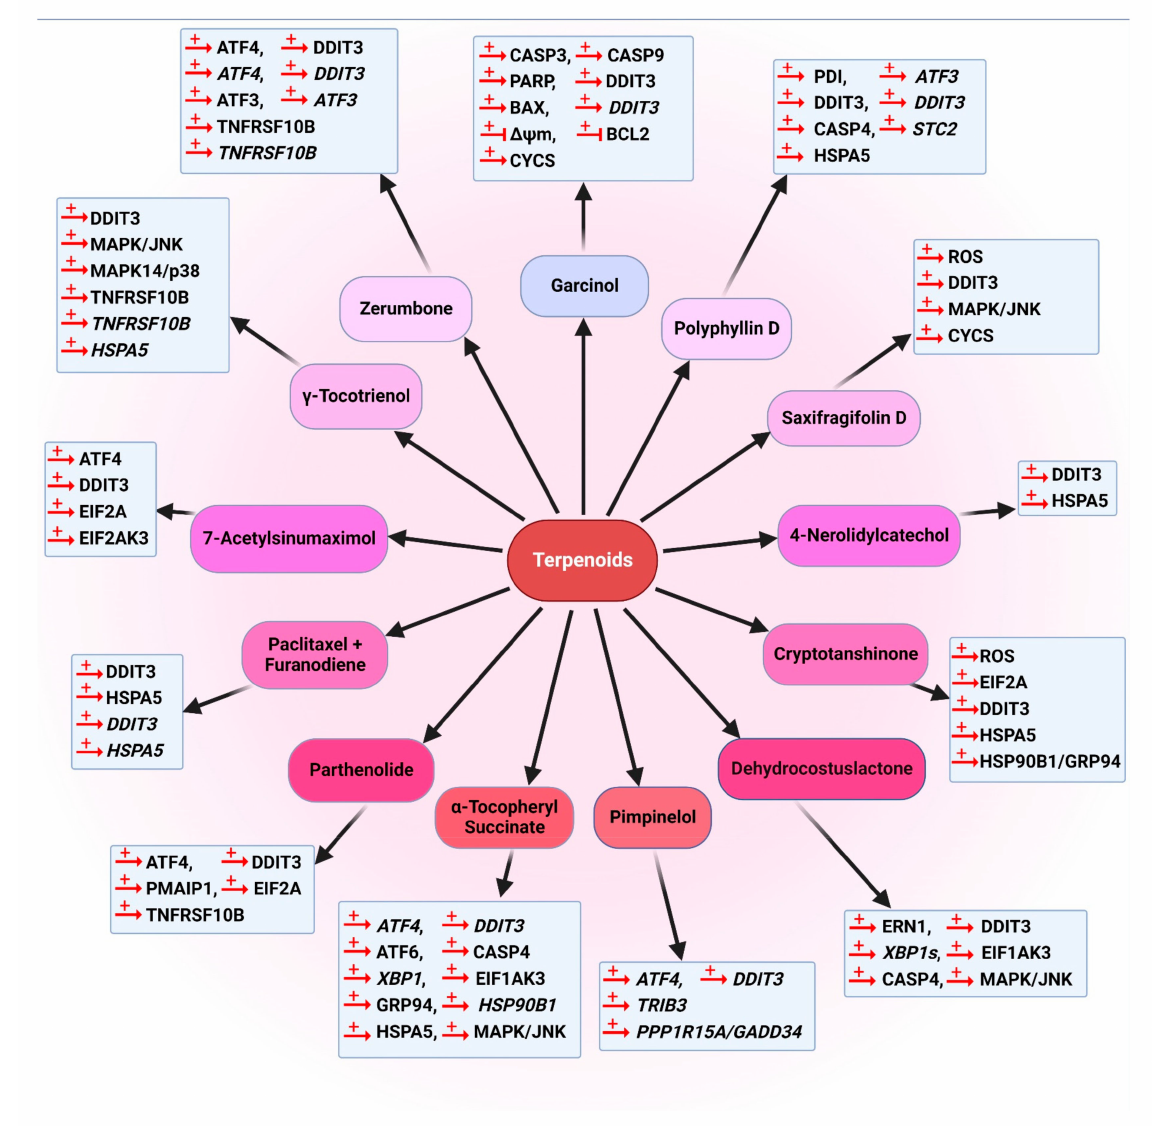
Figure 7. The schematic role of alkaloids on different proteins involved in the autophagy pathway. Alkaloids regulate autophagy in different ways. Vincristine and carbazoles have been demonstrated to inhibit autophagy by suppression of CD24, suppression of the PTEN-AKT-MTOR pathway and Figure 20. The schematic role of terpenoids on the proteins involved in the UPR and ER stress enhancement of SSQTM1/p62. Other alkaloids induce autophagy via activation of AMPK, TSC2, pathways. Terpenoid treatment results in upregulation of the mRNA levels of HMOX1, ATF3, DDIT3, MAPK/JNK-AP-1 and BECN1, and enhance MYC/c-Myc, LC3-II and ATG7 expression. Moreover, HSPA5, HSP90B1/GRP94 and STC2. Moreover, typical ER stress-related proteins such as HSPA5, PDI, inhibiting the AKT-MTOR pathway has a key function in induced autophagy by alkaloids. Moreo- DDIT, EIF2AK3, ERN1, ATF6, ATF4 and HSP90B1/GRP94 increased in the cells treated with these ver, another alkaloid named tetrandrine induces autophagy by suppressing the WNT- CTNNB1/β - compounds. Moreover, these compounds increase protein aggregation and mRNA expression of catenin pathway and decreasing MTA1 expression. → : Indicates activation or an increase in the mentioned protein expression. ATF4, PPP1R15A/GADD34 and TRIB3. In some cases, the expression of TNFRSF10B and increasing protein aggregation of PPP1R15A/GADD34 and TRIB3 are observed. → : Indicates activation or an increase in the mentioned protein expression. : Indicates deactivation or a decrease in the mentioned protein expression. − and +: Indicate the effect of the proteins on different pathways ( − means negative effect and + means positive effect). The figure was created with BioRender.com. Licensing Right VD24OB6Q8E, 21 November